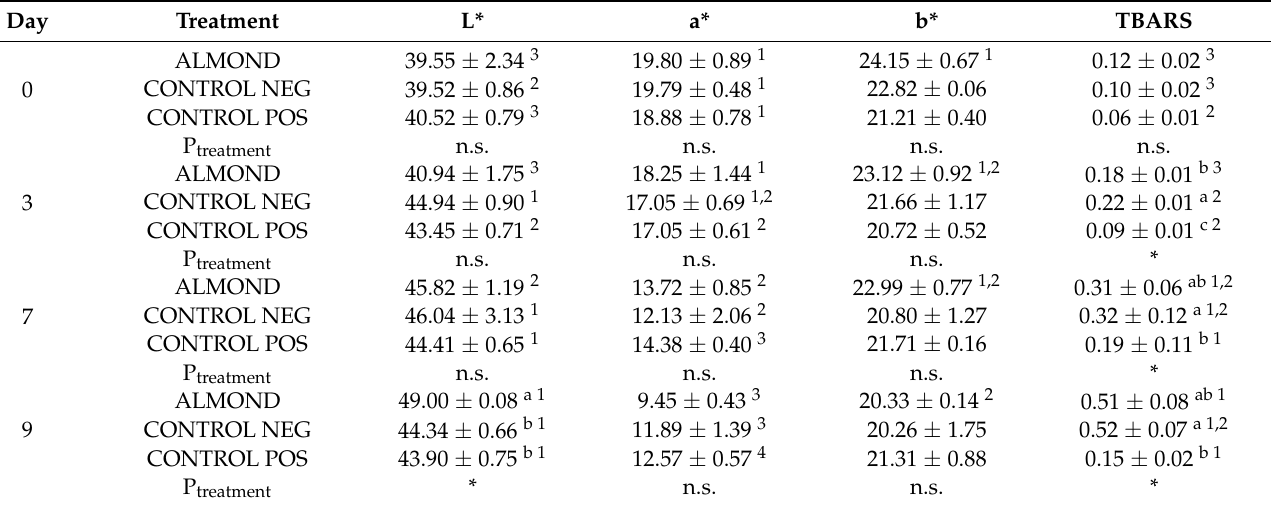
Table 4. Evolution of instrumental color parameters (L*, a* and b*) and TBARS (expressed as mg MDA/kg sample) in pork patties with different treatments stored in MAP for 9 days. Values are reported as mean ± SD (n =